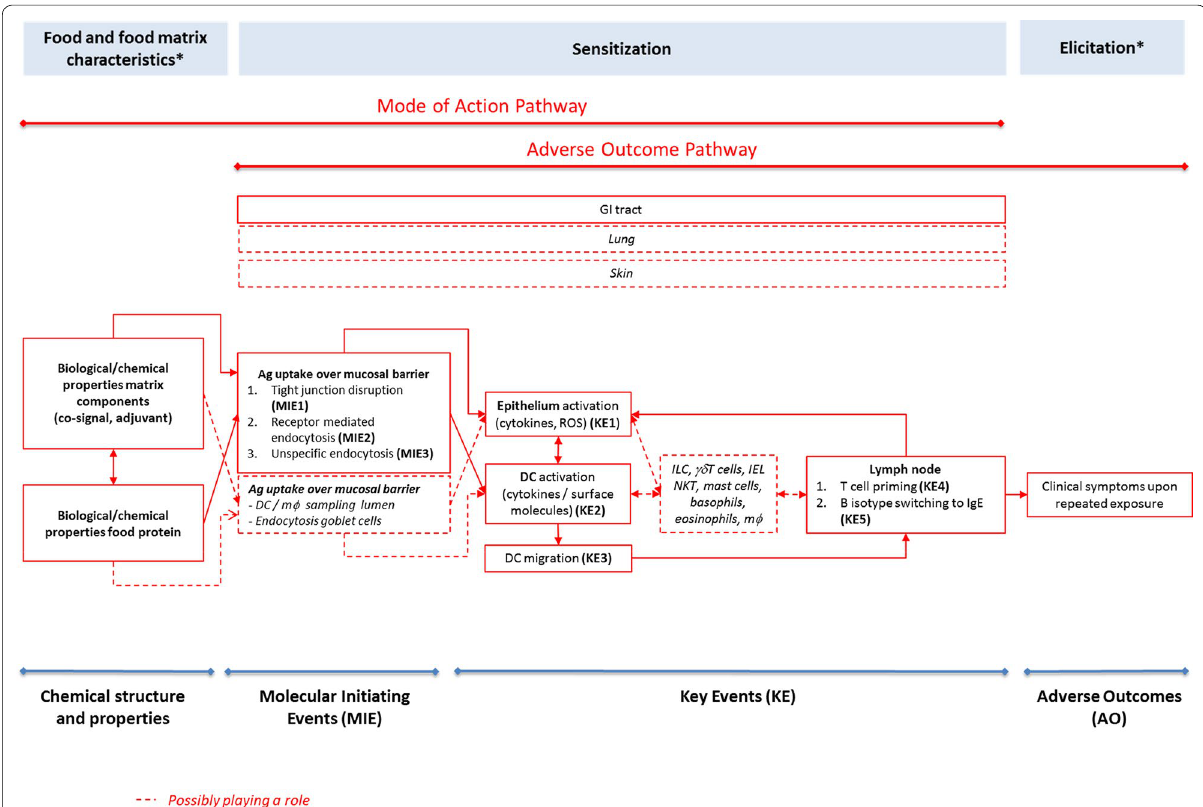
Fig. 1 A tentative MOA including an AOP describing the mechanistic events driving food sensitization induction. Solid boxes and arrows represent events and relationships with substantial evidence for a role in sensitization induction to food proteins. Dashed boxes and dashed arrows represent events, organs cellular components or relationships with circumstantial evidence for a role in the AOP. Ag antigen, GI gastro‑intestinal, ILC innate lymphoid cells, mφ macrophages, NKT natural killer cells, IEL intraepithelial lymphocytes. *Outside the scope of this